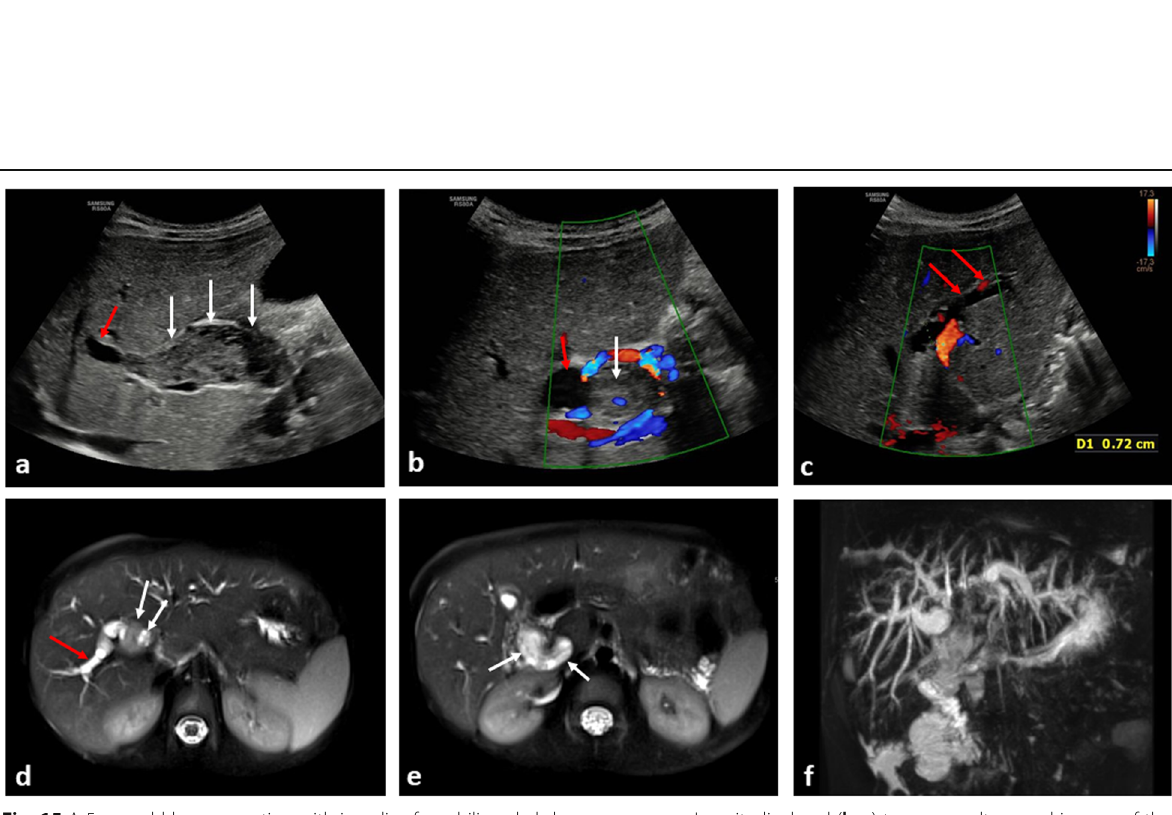
Fig. 15 A 5-year-old boy presenting with jaundice from biliary rhabdomyosarcoma. a Longitudinal and ( b , c ) transverse ultrasound images of the liver at diagnosis, demonstrates a heterogenous mass (white arrows) occupying and distending the common bile duct with downstream intrahepatic biliary dilatation (red arrow). d , e Axial T2-weighted MRI images through the liver confirm the intra-biliary mass (white arrows), with dilatation of right-sided intrahepatic bile ducts (red arrow). f The intrahepatic biliary dilatation is best demonstrated on the 3D-maximum intensity projection (MIP) image of the MRCP (MR